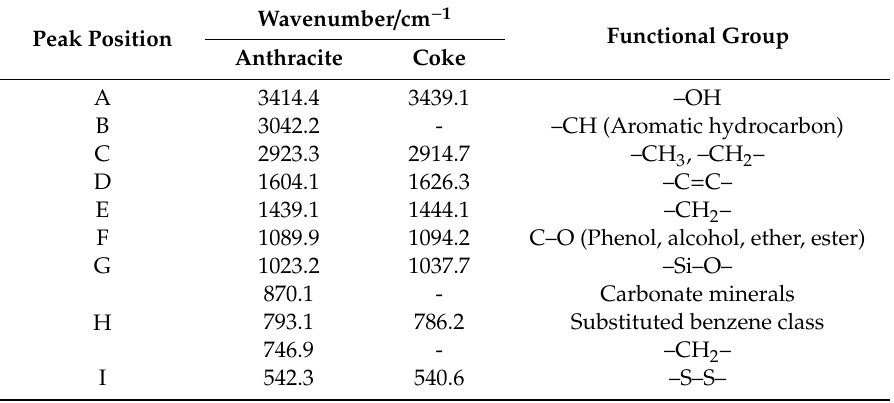
Table 3. Infrared spectrum absorption peak classification of anthracite and coke powder. Peak